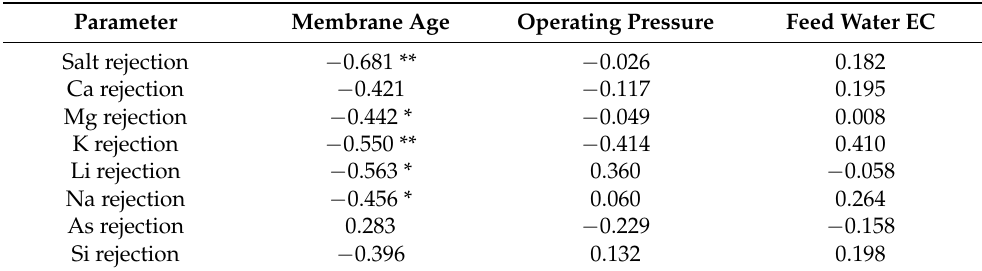
Table 3. Pearson correlation co-efficient of different operational parameters and individual ion rejections of ESPA2-LD-4040 membranes.